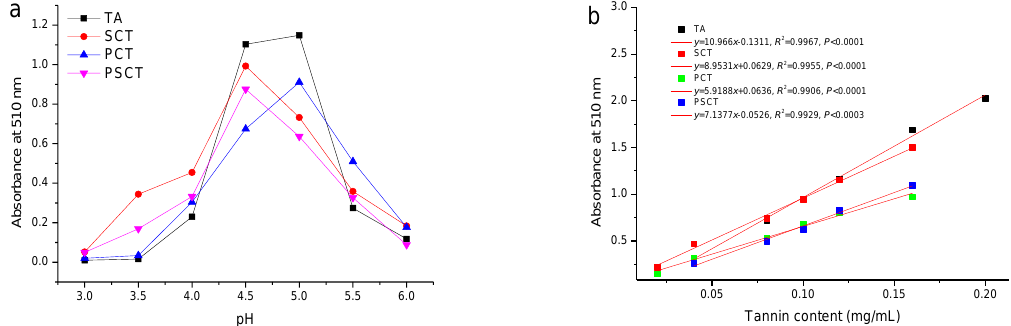
Figure 5. ( a ) The pH dependence of tannin complex formation with BSA determined by UV-Vis spectra. ( b ) Titration curves of a known amount of protein with increasing amounts of tannins of Chinese gallnut, plum fruits, sorghum grain, and P. strobilacea . TA, tannins isolated from Chinese gallnut; PCT, tannins isolated from plum fruits; SCT, tannins isolated from sorghum grain; PSCT, tannins isolated from P. strobilacea .